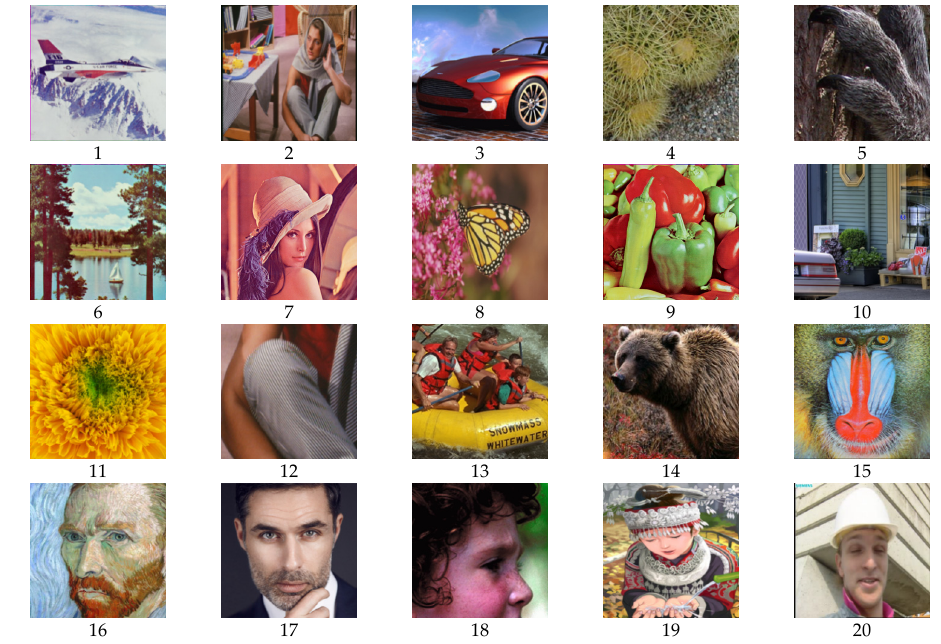
Figure 4. Several classical testing images.